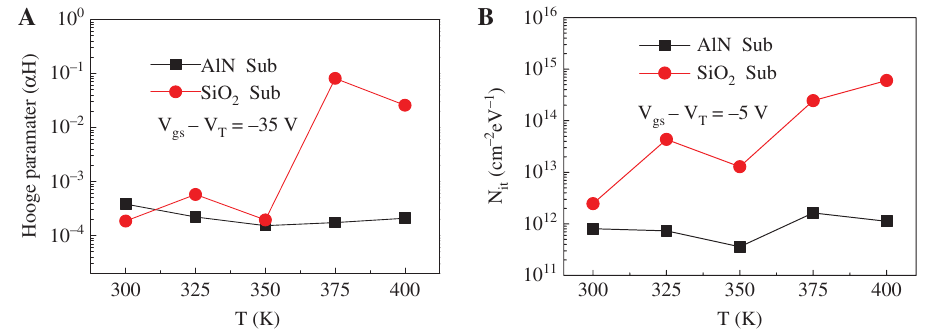
and N for BP FETs on two substrates. H it ) in the linear region and (B) interface charge trapped density ( N H